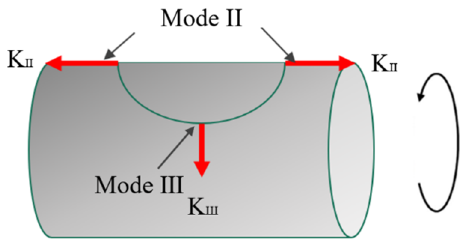
Figure 8. The modes of longitudinal crack propagation under torsional loading.